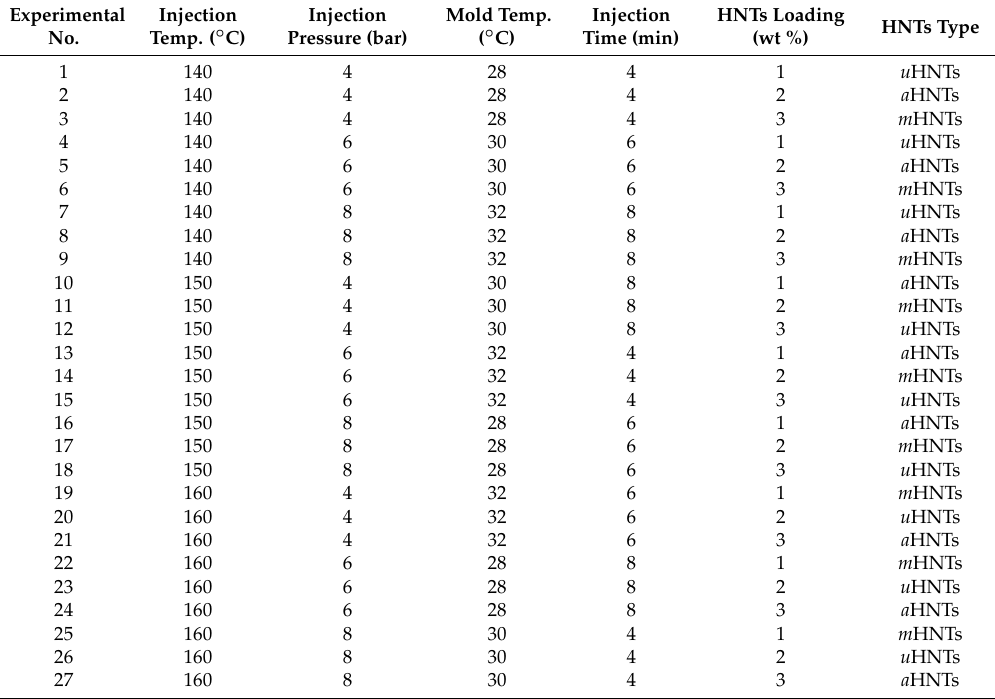
Table A1. Experimental layout as per the L 27 (3 13 ) model.